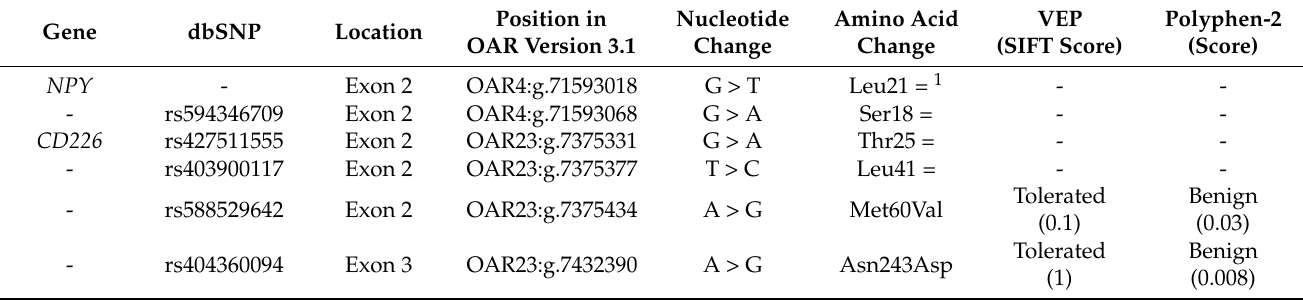
Table 3. Information regarding the location and amino acid substitution effect of the identified SNPs according to the Variant Effect Predictor and PolyPhen-2 software in the NPY and CD226 genes. Scores are indicated in brackets. The SNPs are ordered according to their positions in the Oar3.1 genome version (Oar3.1: GenBank acc. Numbers NC_019461 and NC_019480 for NPY and CD226 , respectively).